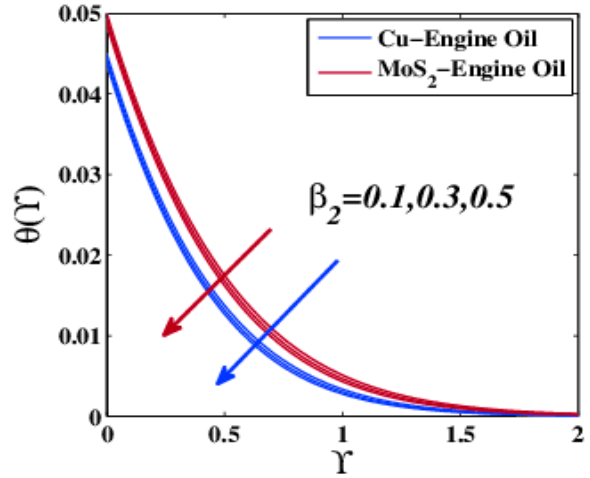
Figure 6. The effect of β 1 on temperature variation θ ( Y ) .